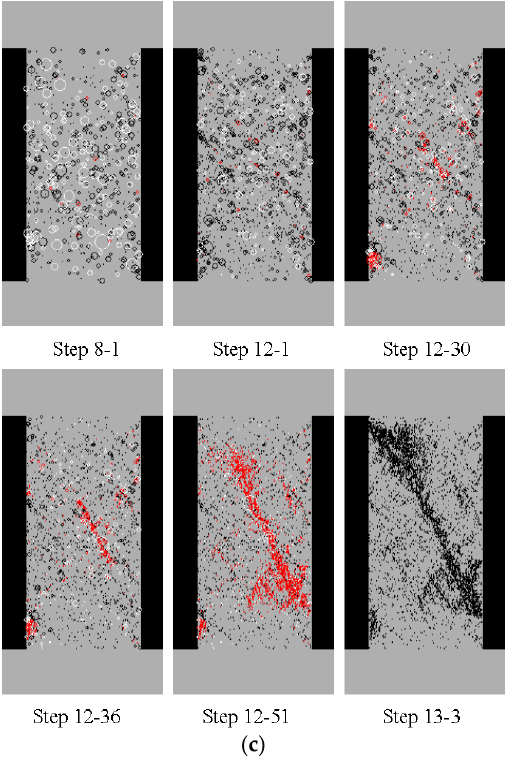
Figure 10. Numerical time distribution sequence of AE positioning in the sample loading process. ( a ) Acoustic emission results of Model 1’s loading process. ( b ) Acoustic emission results of Model 2’s loading process. ( c ) Acoustic emission results of Model 3’s loading process.